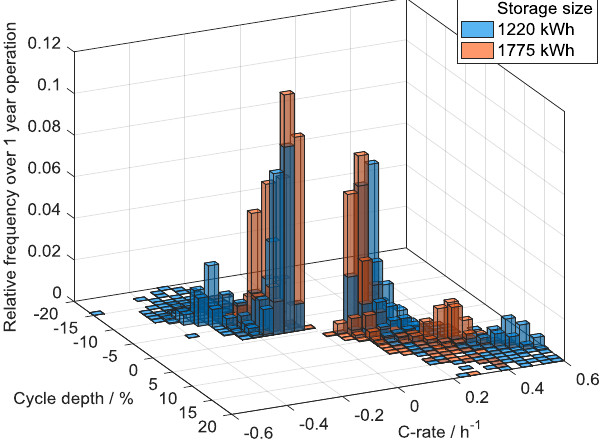
Figure 11. Relative frequency of cycle depth and C rate in 2014.